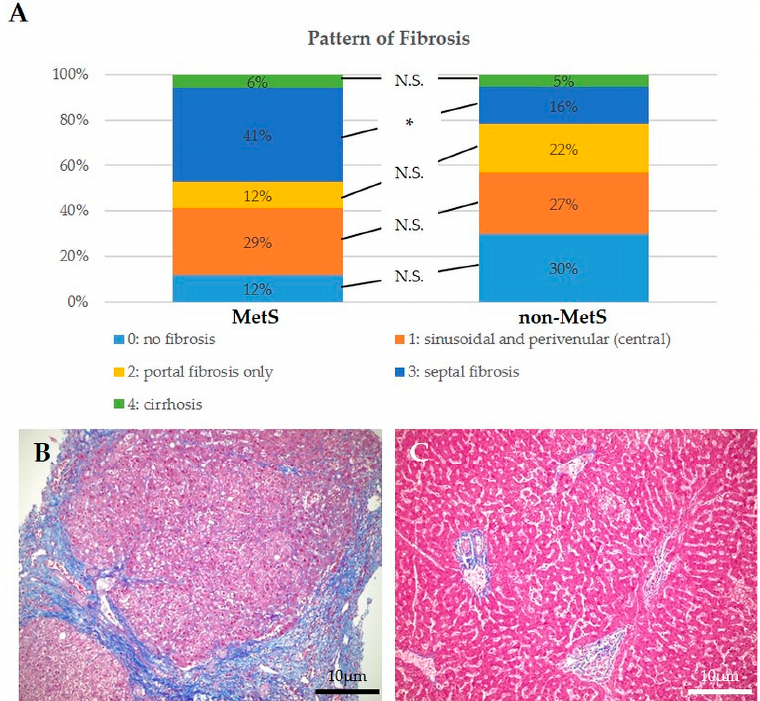
Figure 3. MetS and non-MetS peri-iCCA tissue showed different patterns of hepatic fibrosis. ( A ) The extent and pattern of fibrosis is different between the two groups. A greater proportion of MetS iCCAs showed fibrosis deposition, particularly septal, as compared to non-MetS iCCAs. ( B ) Representative micrographs of cirrhotic progression in a patient with MetS and hepatic steatosis. ( C ) Representative micrograph of a non-MetS iCCA lacking fibrosis. Tissue specimens were taken from peritumoral areas. Staining: Masson’s trichrome. * p < 0.05 using χ 2 test; N.S., not significant.